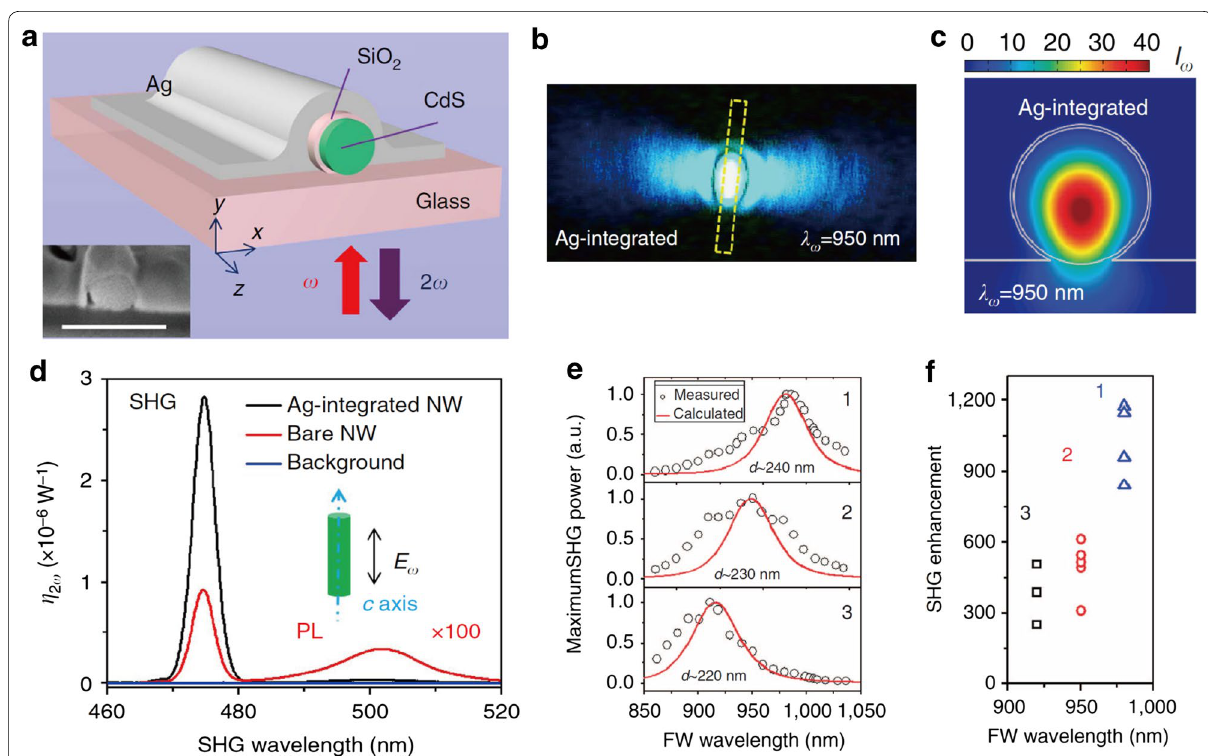
Fig. 6 Enhanced second harmonic generation from CdS NWs coupled to plasmonic nanocavities. a Schematic illustration of a plasmonic NW device for enhanced SHG comprising a nonlinear CdS NW covered with Ag nanocavity. The fundamental wave (ω) is illuminated through the glass substrate while collecting the back‑scattered second harmonic (2 ω ) signals. Inset shows an SEM image of the fabricated plasmonic NW device. b Dark‑field optical microscopy image showing SHG signals (blue) from a CdS NW coupled to a Ag nanocavity device (yellow dashed rectangle). c Calculated electric field intensity distribution ( I ω | E ω | 2 ) of the fundamental wave. d Estimated SHG conversion efficiencies as a function of SHG = wavelength emitted from plasmonic nanocavity‑integrated (black) and bare (red, 100) CdS NWs. e , f Size‑ and wavelength‑dependent SHG power × and enhancement ( a – f are adapted from